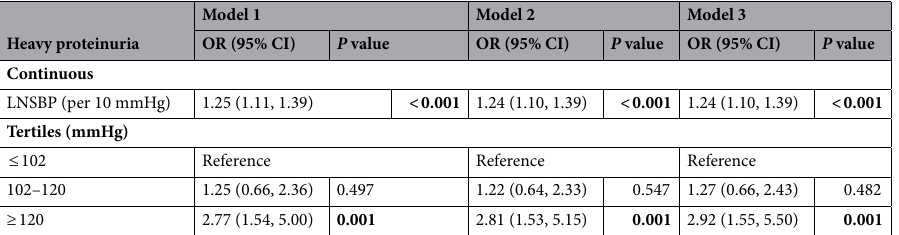
Table 2. The results of the logistic regression model to explain LNSBP related to heavy proteinuria. Model 1: Univariable model; Model 2: Adjusted for age and sex; Model 3: Model 2 + current smoking, eGFR history of hypertension or diabetes, and etiology of CKD. LNSBP the lowest nocturnal systolic blood pressure.